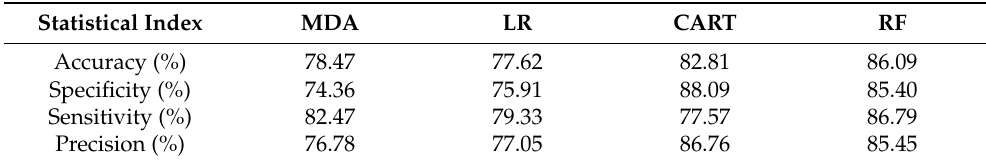
Table 3. Predictive capability of models using training data.